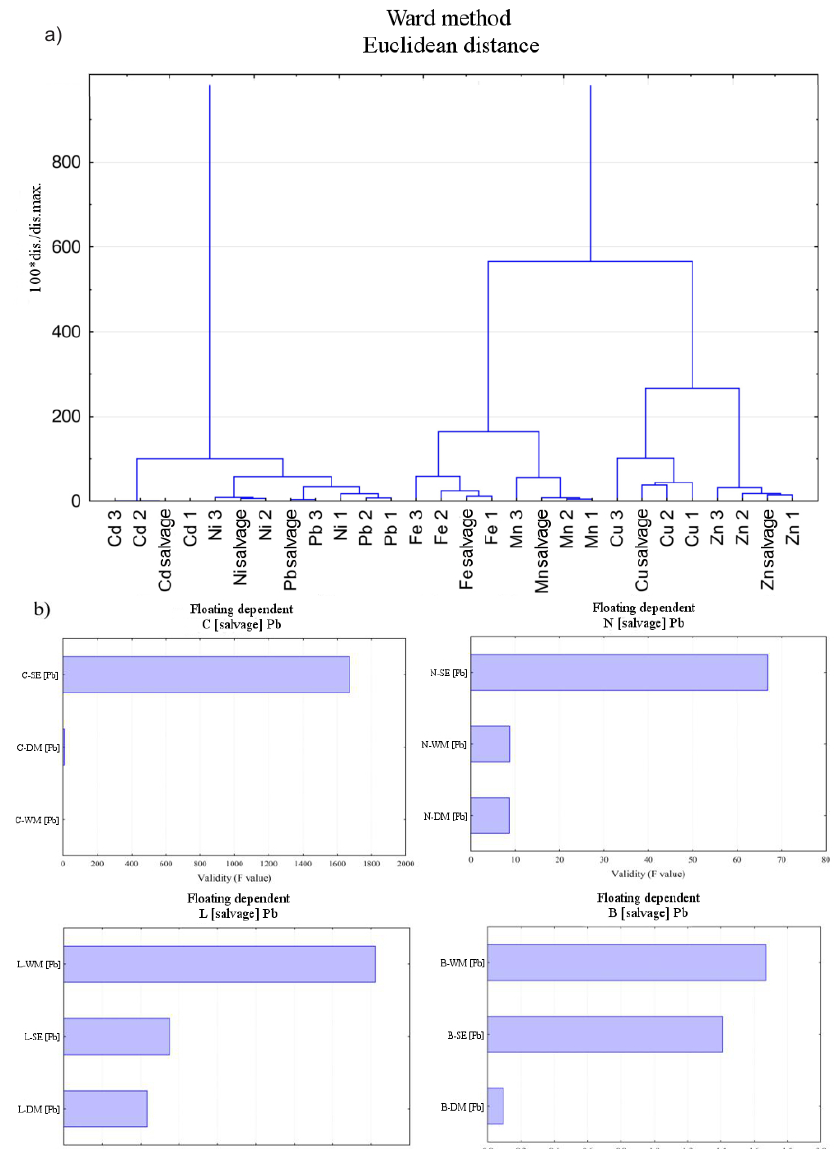
Figure 6. a) Horizontal Hierarchical Tree Plot of the cluster analysis of the examined analyses and methods of preparing samples, b) A variables’ importance plot for sample preparation in relation to the expected